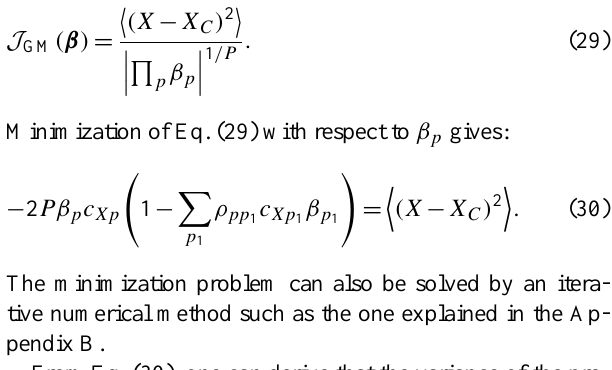
Fig. 3. The long lead time mean square error (MSE) evolution for Lorenz model with small model error ( (cid:14)r = 2 : 5 (cid:2) 10 (cid:0) 3 ) and with 5 (cid:2) 10 5 ensembles of 500 members. The number after the regression method denotes the predictor number.